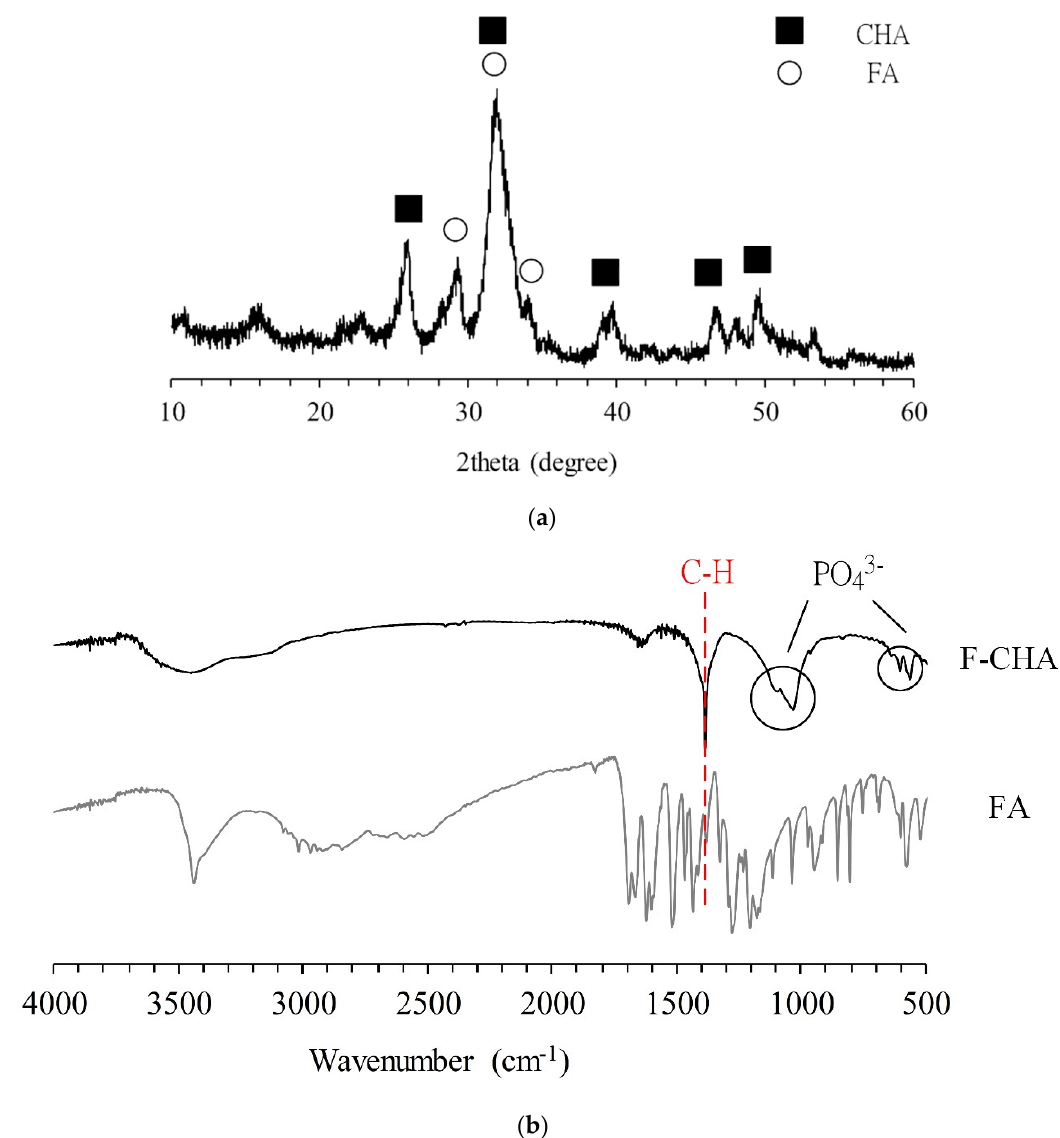
Figure 3. XRD pattern ( a ) and IR spectrum ( b ) of heparin-templated CHA nanorods impregnated with ferulic acid (F-CHA).